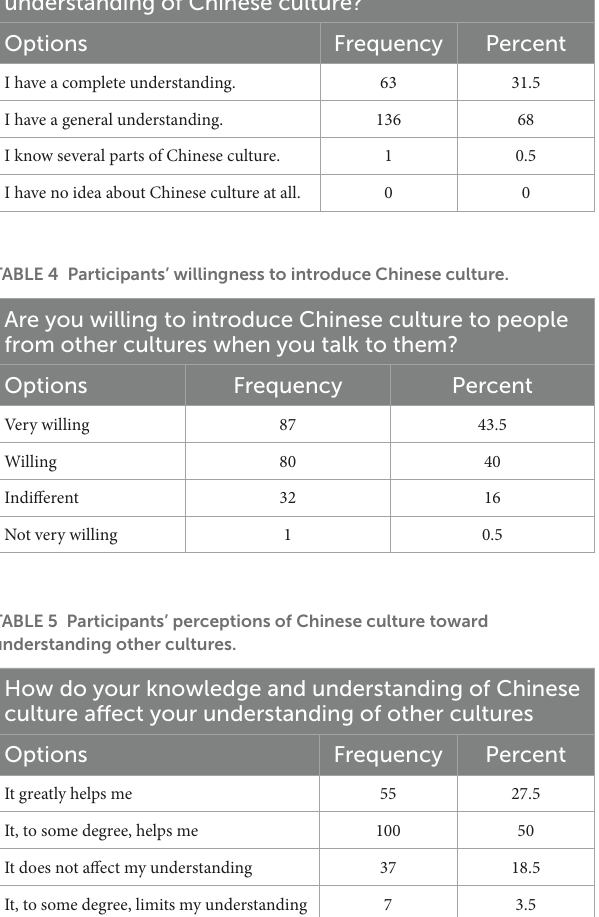
TABLE 3 Participants’ knowledge of Chinese culture. To what degree do you describe your knowledge and understanding of Chinese culture?